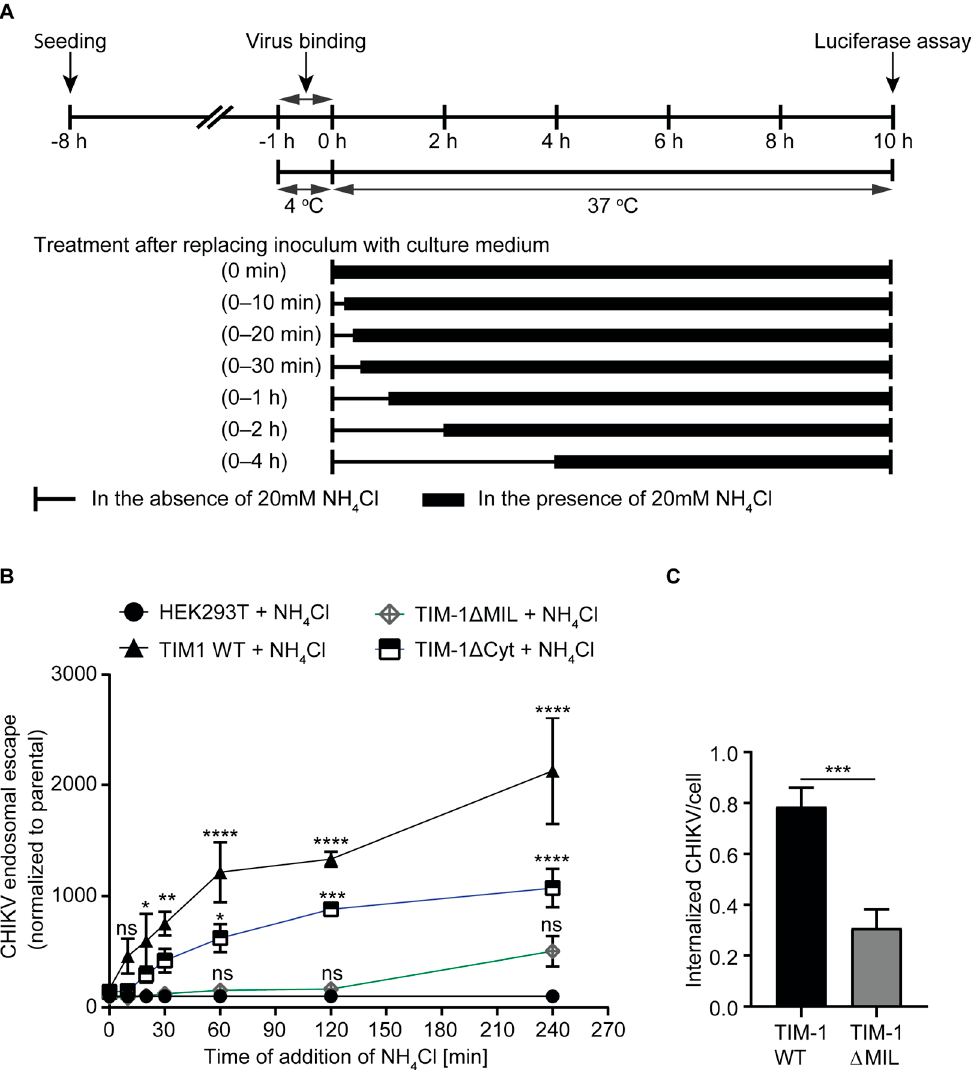
Figure 4. Entry kinetics of CHIKV are altered by TIM-1. ( A ) Scheme showing binding and entry assay. CHIKV (Asian genotype) encoding nano-luciferase fused to E2 glycoprotein (nLuc-CHIKV) was added to parental and TIM-1 expressing HEK293T cells, which were subsequently incubated at 4 ◦ C for 1 h to synchronize binding. After washing, cells were transferred to 37 ◦ C and medium with 20 mM NH 4 Cl was added at indicated time points. Assay was stopped after 10 h of incubation at 37 ◦ C and relative endosomal escape determined by luciferase assay. ( B ) Entry kinetics of nLuc-CHIKV in the indicated cell lines normalized to parental HEK293T cells at each time point. ( C ) Live cell imaging of internalized CHIKV. Cells were inoculated with fluorescent Asian mc-CHIKV at MOI of 50 and monitored by confocal microscopy. After 20 min of live imaging of fluorescent mc-CHIKV (Asian genotype) and cells at 37 ◦ C, trypan blue was added to quench extracellular particles and only internalized viruses were imaged and counted using ImageJ. The error bars represent standard errors of the mean (SEM). Statistical significance was calculated using Dunnet’s multiple comparisons test (2way ANOVA) (B) and Welch t -test (C) with * p < 0.05, ** p < 0.01, *** p < 0.001 and **** p < 0.0001.